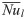
Effect of the inclination angle α on Nu¯l for different types of porous media and porosities.